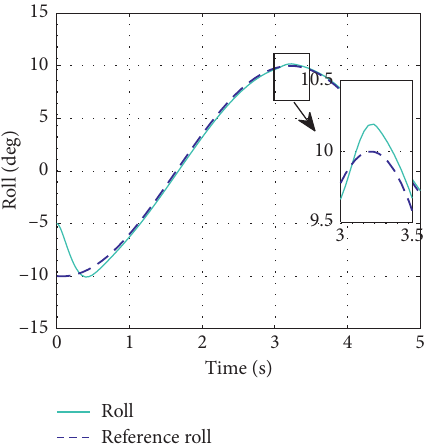
Figure 4: The tracking control result of roll angle of the aerial tree-pruning robot.